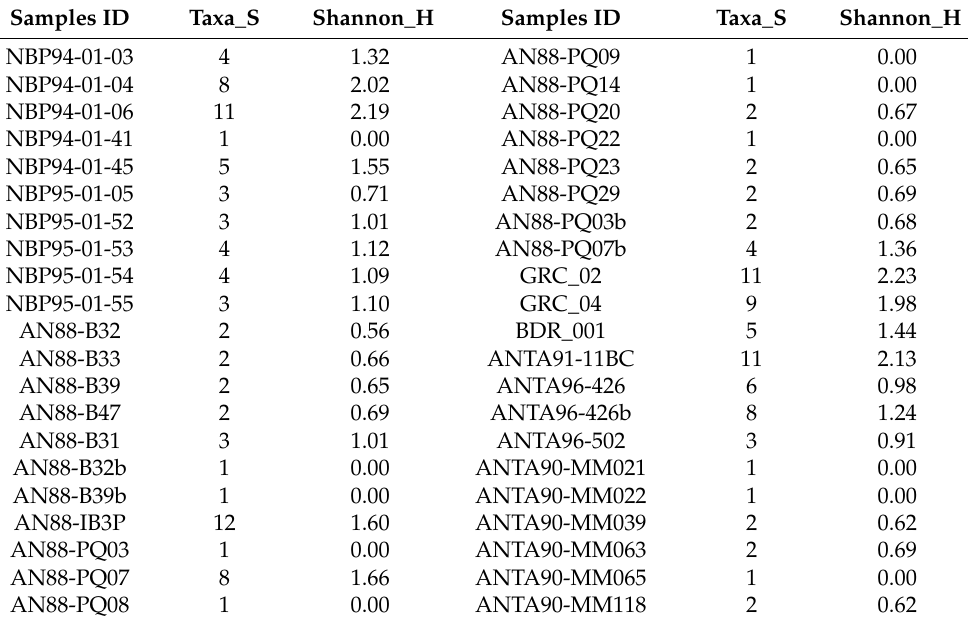
Table 1. Species Richness (Taxa_S), and the Shannon Index (Shannon_H) calculated for in situ ostracods in each